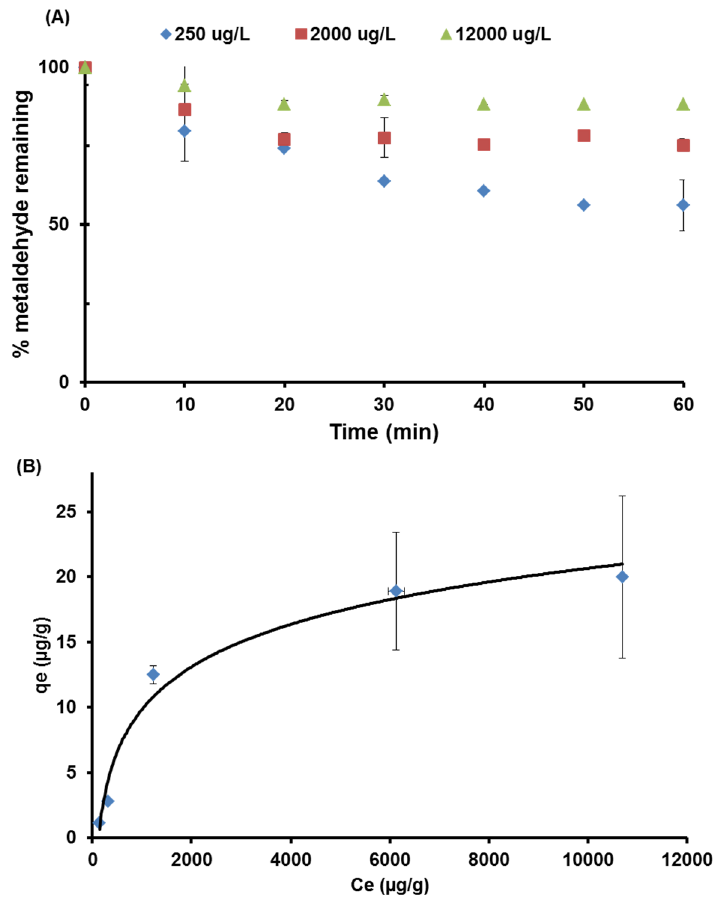
Figure 1. ( A ) Kinetics of metaldehyde adsorption onto Nyex TM 1102.